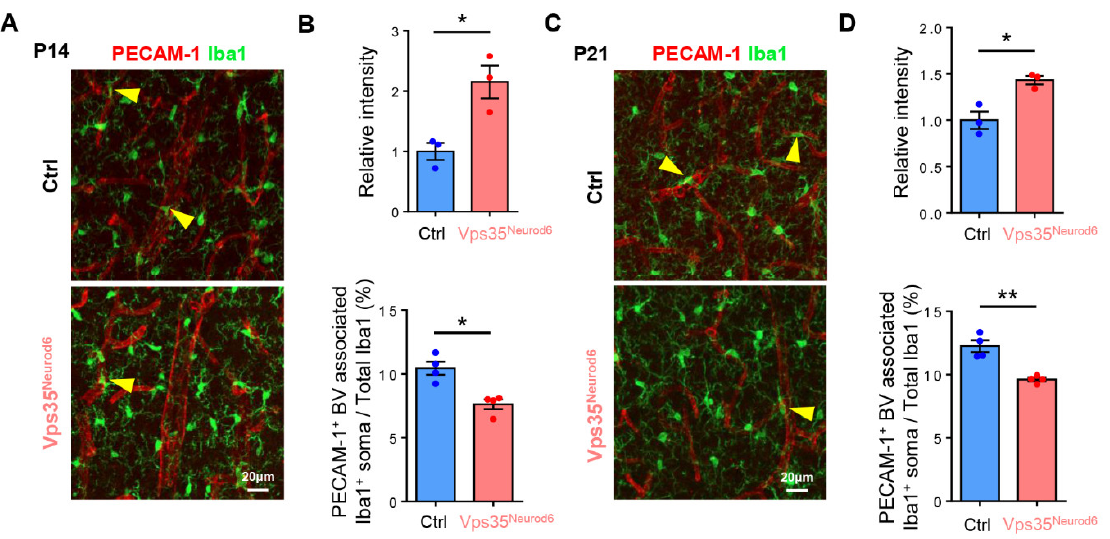
Figure 7. Altered Iba1 + microglia distribution in Vps35 Neurod6 cortex. ( A ) Representative images of cortical brain sections coimmunostained with PECAM-1 and Iba1 at P14. ( B ) Quantification analysis of Iba1 intensity and PECAM-1 + BV-associated Iba1 + soma of control and Vps35 Neurod6 mice (n = 3~4 mice per group; two-tailed unpaired t test). ( C ) Representative images of cortical brain sections coimmunostained with PECAM-1 and Iba1 at P21. ( D ) Quantification analysis of Iba1 intensity and PECAM-1 + BV-associated Iba1 + soma of control and Vps35 Neurod6 mice (n = 3~4 mice per group; two-tailed unpaired t test). Scale bars as indicated in each panel. Individual data points are shown as dots with group mean ± SEM; * p < 0.05; ** p < 0.01; ns., not significant.